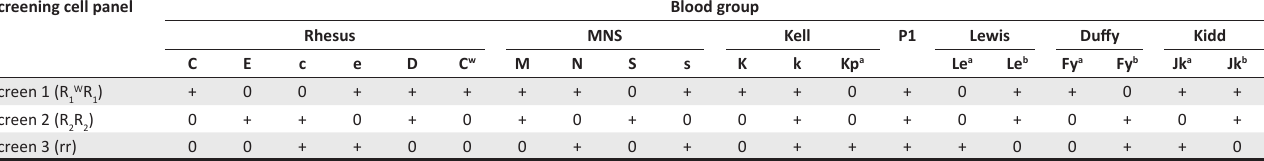
TABLE 1: Screening cells used and blood groups tested for alloantibodies, Bugando Medical Centre, May 2017–June 2017. † Screening cell